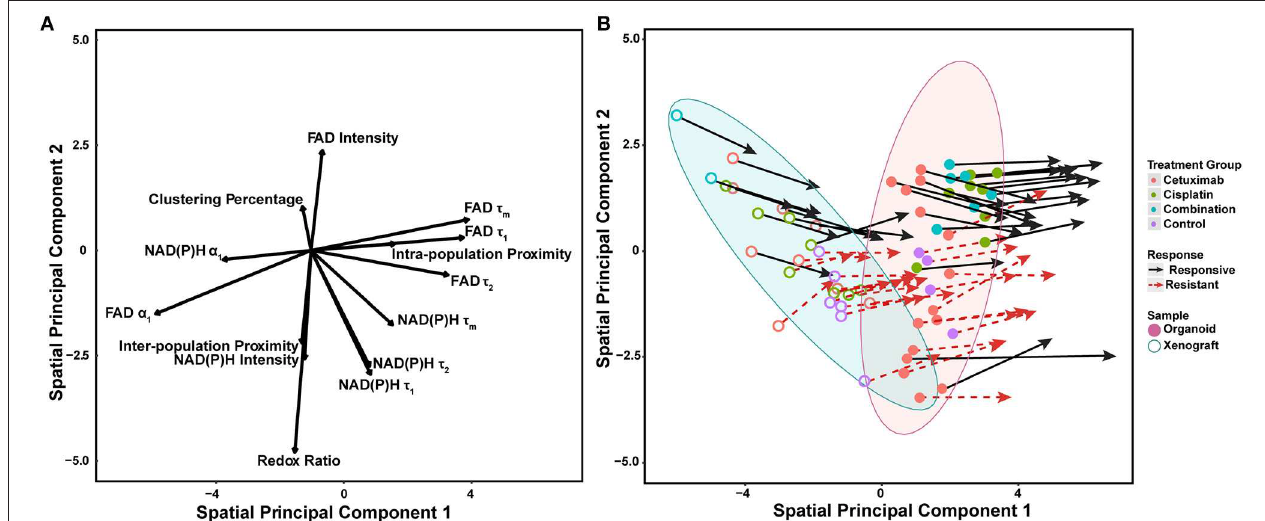
FIGURE 6 | Multivariate analyses of metabolic activity and spatial organization in xenografts and organoids. (A) Loading vectors for all treatment conditions across both organoids and xenografts. (B) The same spatial PCA plot as (A) , with treatment groups and model systems plotted to observe spatial clustering patterns. Points correspond to the spatial PCA score for a single organoid (filled circle) or xenograft (open circle). Arrows represent differences between average spatial PCA scores of an organoid or xenograft and the average spatial PCA score of their cell neighborhood.